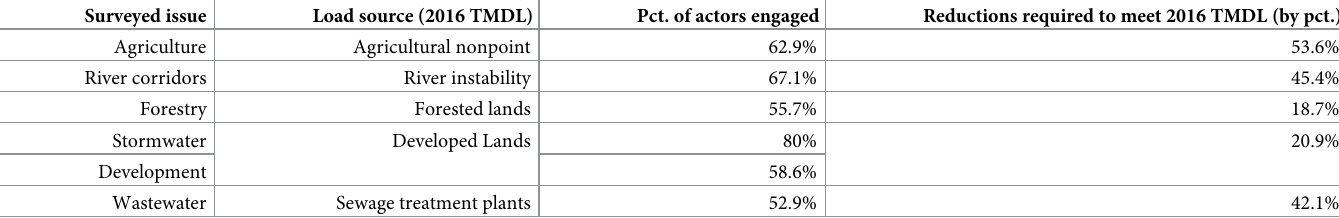
Table 3. Actor engagement in surveyed water quality-related issues and load allocations from the 2016 TMDL. Issue engagement is non-exclusive, so the percentages sum to more than 100%. Surveyed